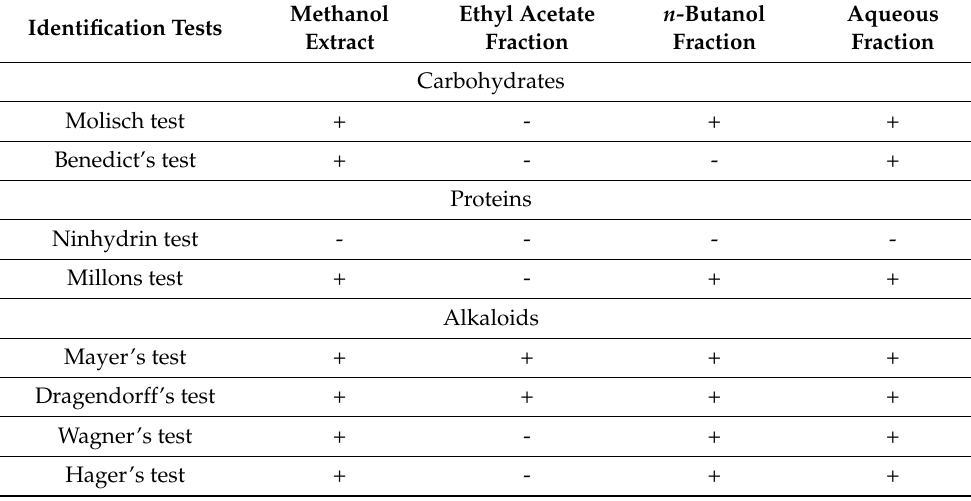
Table 1. Phytochemical analysis of B. calliobotrys